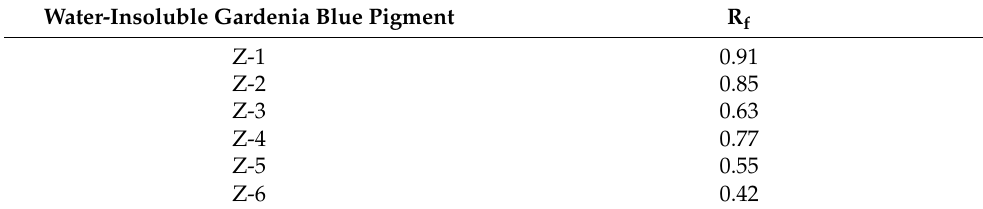
Table 5. The R f of different spots of water-insoluble gardenia blue pigment.